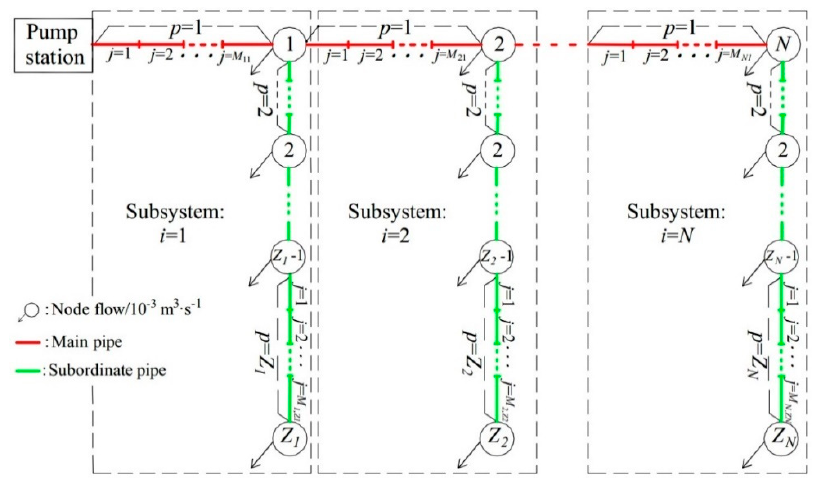
Figure 1. Generalization diagram of pressurized tree-type water distribution network (WDN).